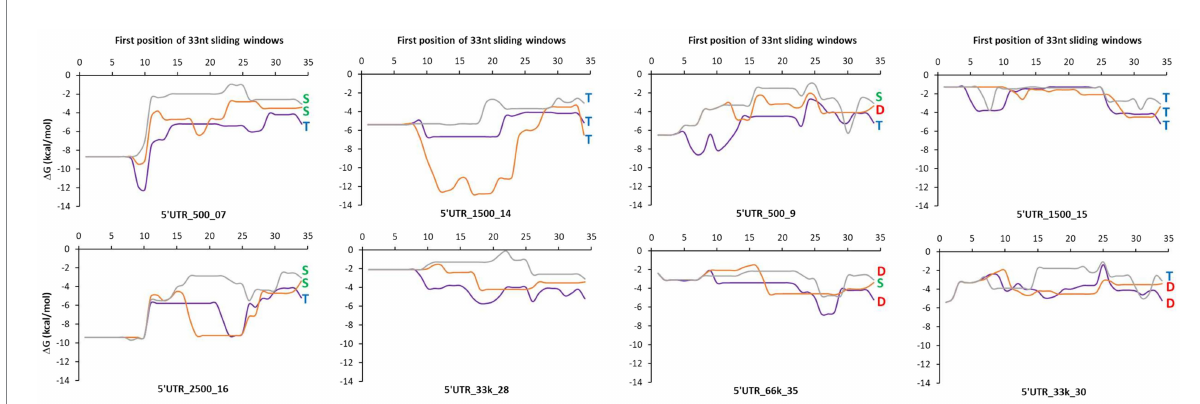
FIGURE 5 A sliding window analysis of the minimum free energy in the translation initiation region. A 33-nucleotide long sliding window was applied in the translation initiation region (TIR) of each mRNA of reporter genes fused to the eight selected 5’UTRs. The TIR sequence ( − 33 to +33 bp region relative to the start codon) comprises the synthetic 5’UTR and the first 11 codons of the downstream gene. The minimum free energy was calculated in each window using the mfold software. The minimum free energies of lacZ are represented by the purple curve, of txAbF by the orange curve and of msfGFP by the gray curve. Blue T letter: mainly a transcriptional control; Green S letter: a shared transcriptional and degradational control; Red D letter: mainly a degradational control. 5’UTR_33k_28 was used as a reference for the study of the degradational/transcriptional controls.